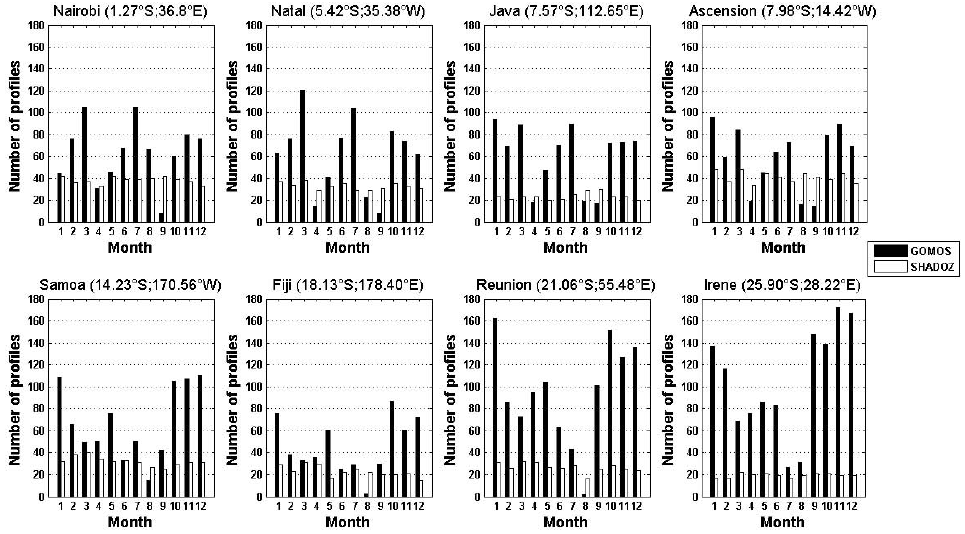
Fig. 2. Monthly distributions of the number of the GOMOS dark occultations (black bars) and SHADOZ profiles (white bars). The GOMOS dataset has a global coverage for the period 2002 to 2008, while the SHADOZ dataset covers the period between 1998 and 2008 and includes 8 southern tropical/subtropical